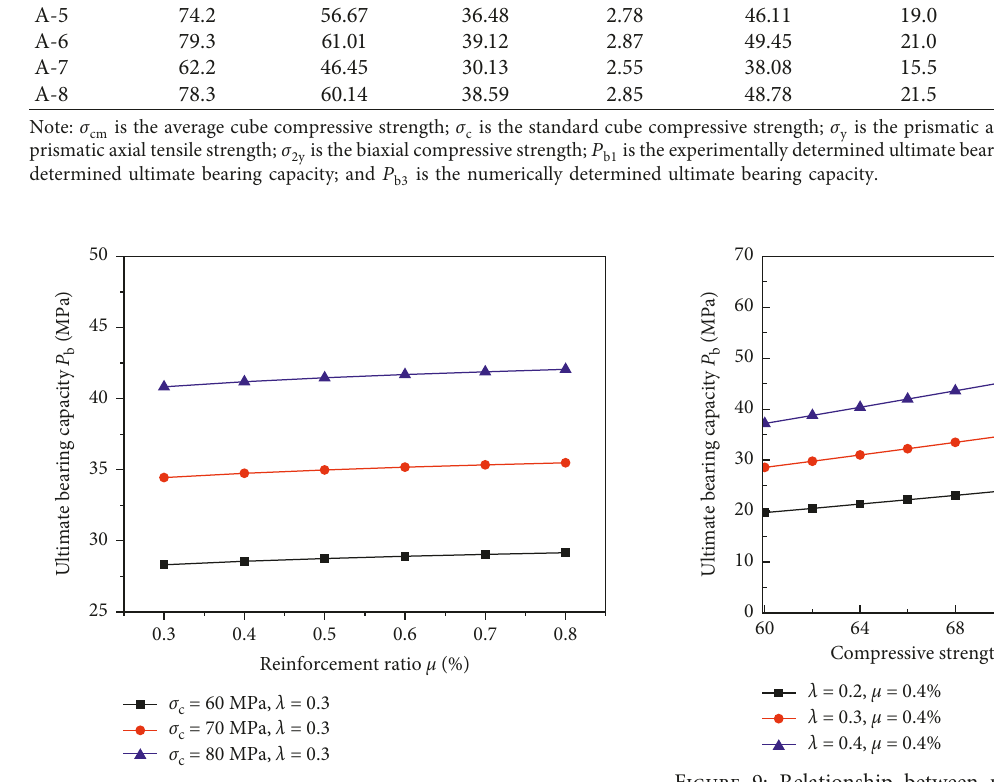
Figure 8: Relationship curve between ultimate bearing capacity and reinforcement ratio.